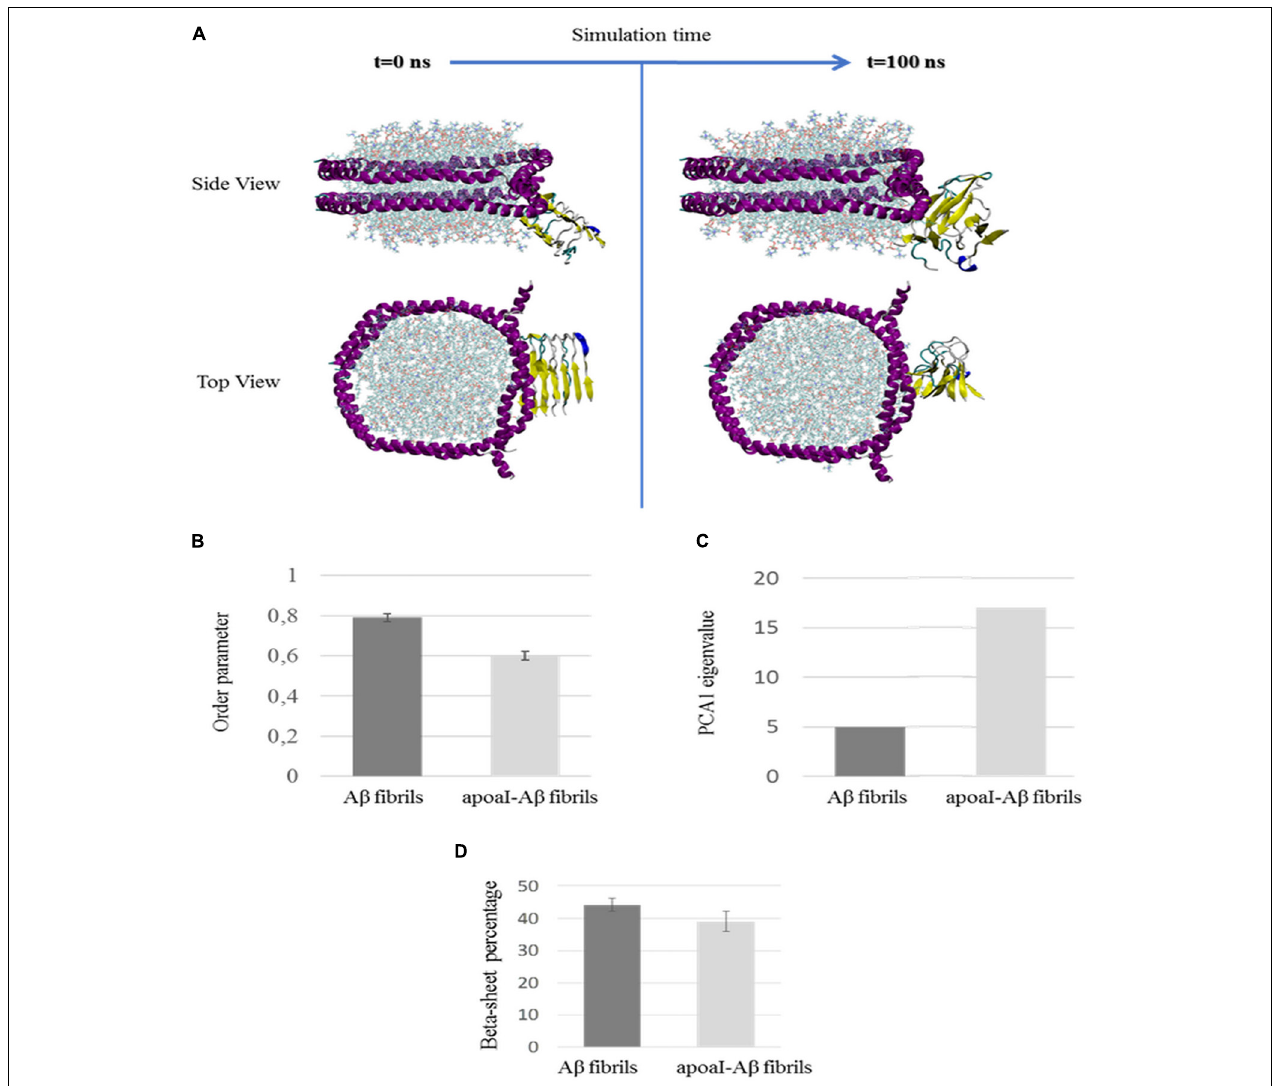
FIGURE 8 | Molecular dynamic simulation analysis. (A) Visual inspection of the apoA-I interaction with A β fibril at the beginning ( t = 0 ns) and at the end ( t = 100 ns) of the MD simulation. The side-view and top-view representations are reported in the upper and lower panels, respectively. Yellow represents A β 17 - 42 and magenta represents apoA-I. (B–D) The destabilization of A β fibril by discoidal apoA-I-HDL obtained by MD simulations is shown. (B) the order parameter calculated at the equilibrium, (C) the eigenvalue of the first PCA vector, and (D) the β -sheet content of A β fibril alone in water and in complex with